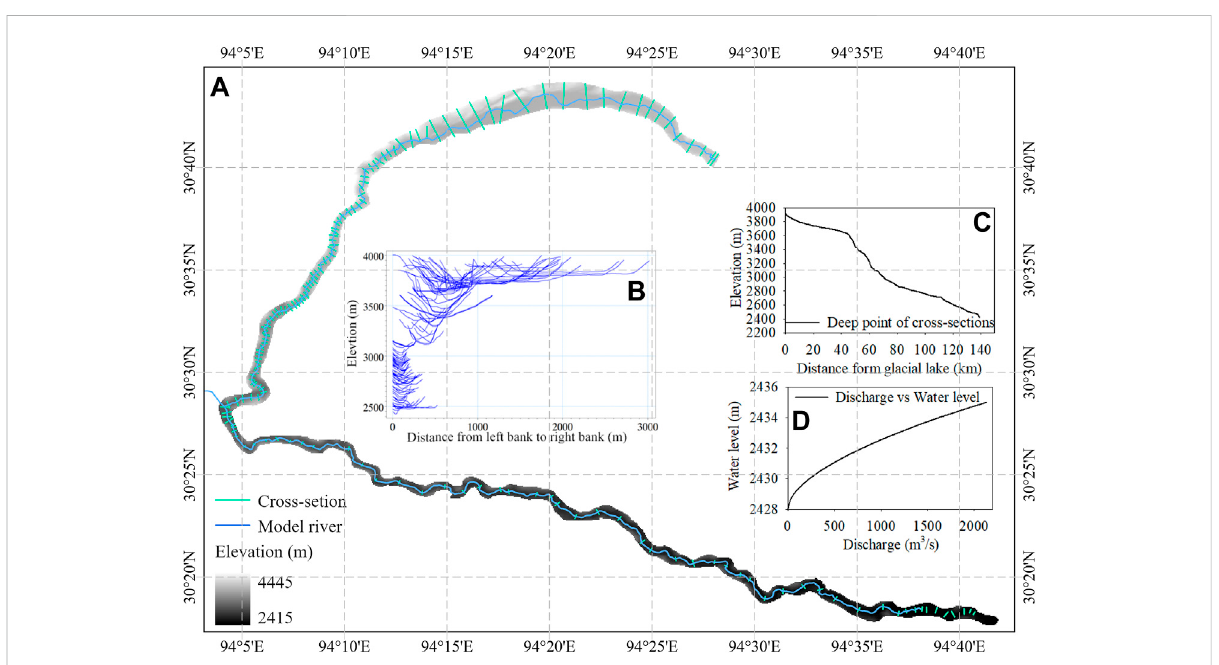
FIGURE 2 River channel, cross-sections,and downstream openboundary ofthe study area. (A) is simulated channel, (B) istheshape of all cross-sections, (C) indicates the gradient of the river channel, (D) is the downstream boundary